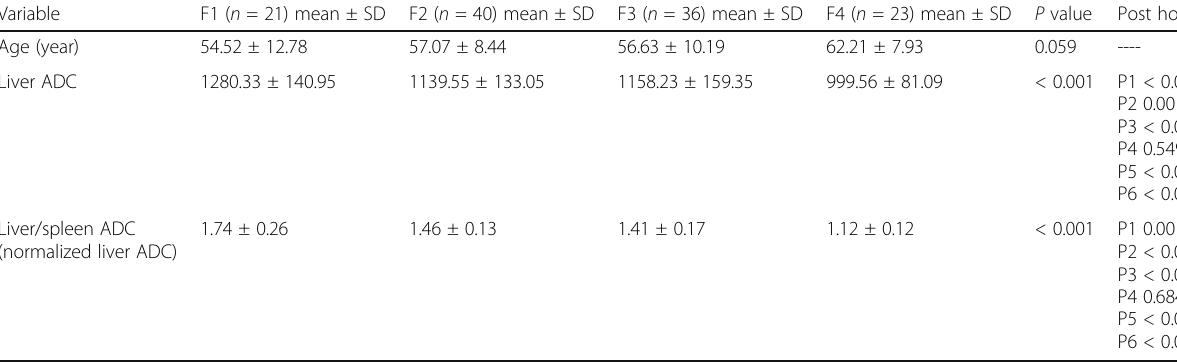
Table 2 Age and different ADC measurement of different fibrosis stages among cases